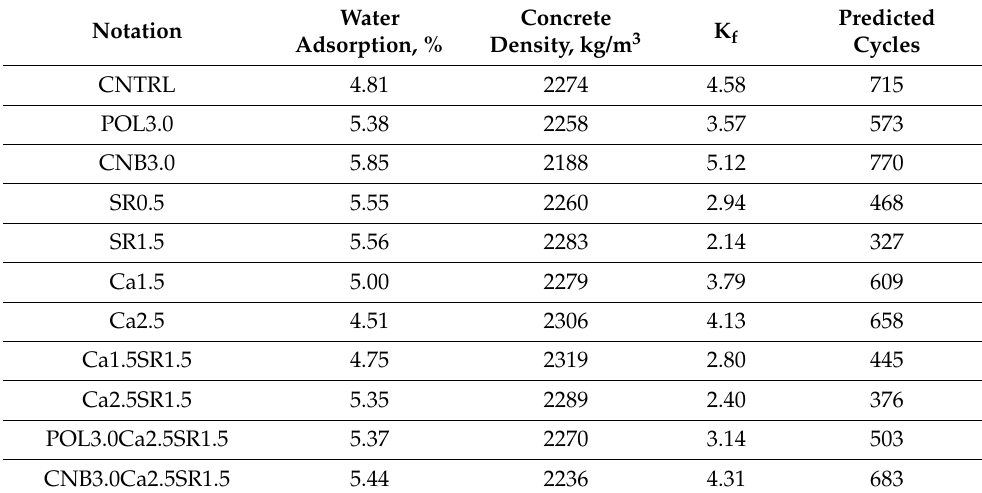
Table 6. Durability parameters of hardened